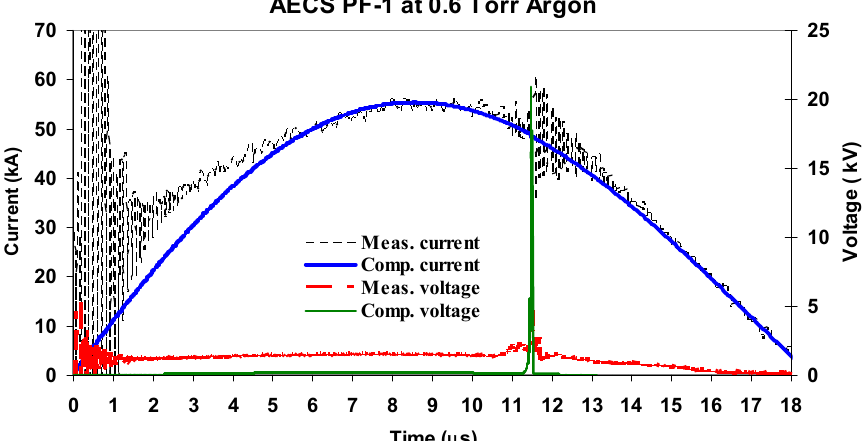
Figure 3. The measured and computed waveforms of the current and voltage in the AECS PF-1 plasma focus device at p 0 = 0.6 Torr of argon.